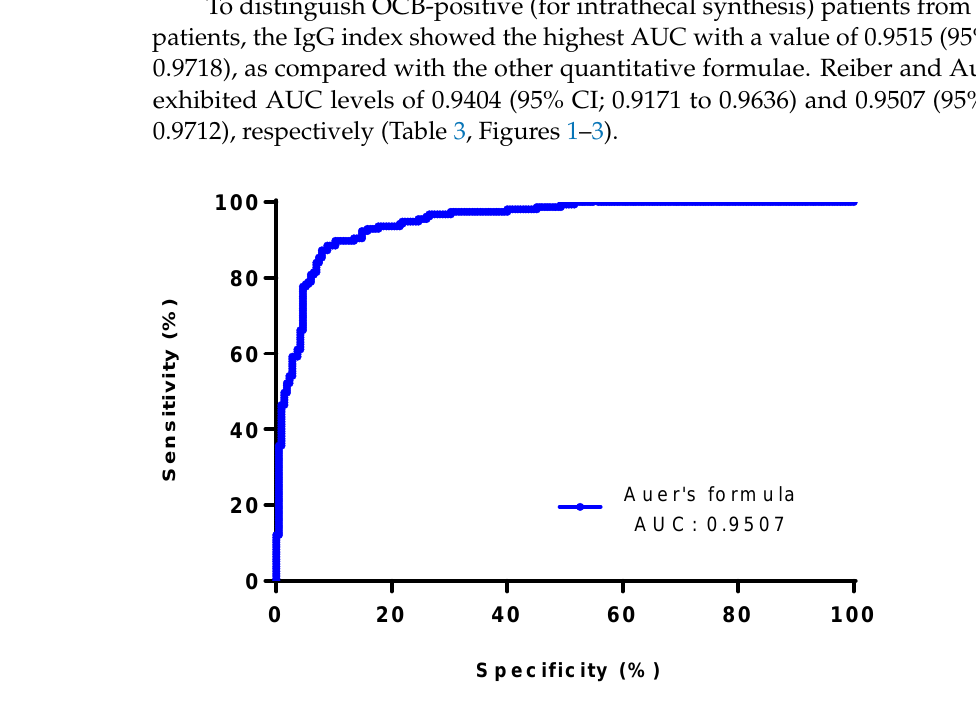
Figure 1. The ROC curve of Auer’s et al. formula for discriminating between OCB-positive (n = 157) and negative (n = 215) patients. Abbreviations: AUC, area under the curve.